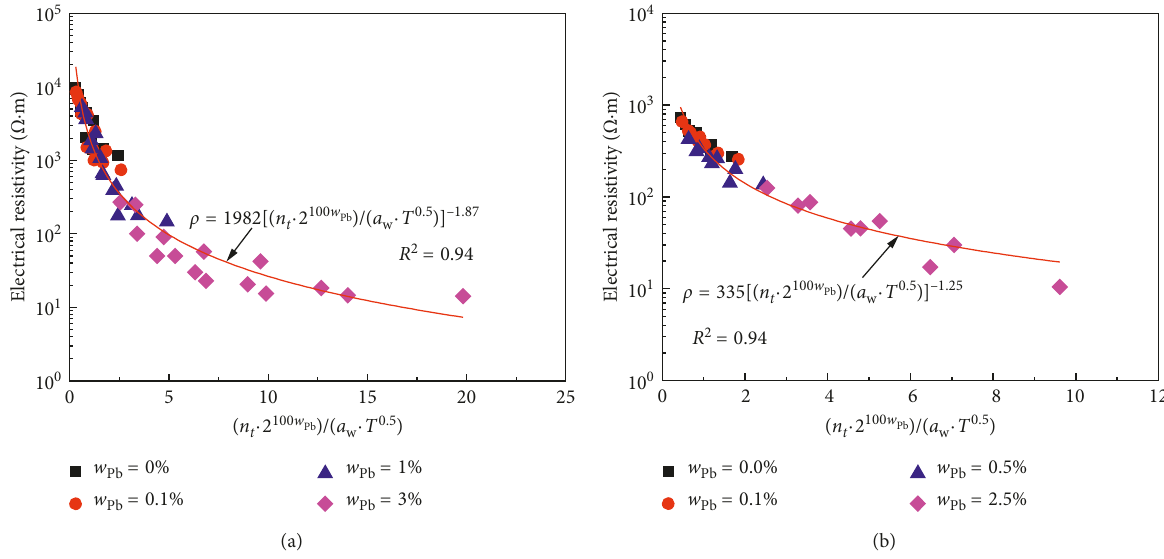
100 w Pb n T 0 . 5 : (a) specimens of soil S1; (b) specimens of soil S2. / a w t · 2 ( ) ·